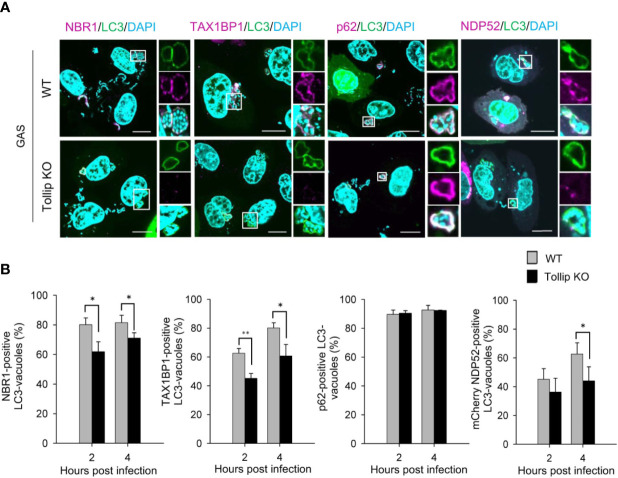
Tollip is required for the recruitment of NBR1, TAX1BP1, and NDP52 to GAS-containing LC3 vacuoles. (A) Wild-type and Tollip-knockout HeLa cells were transfected with EmGFP-LC3 or co-transfected with EmGFP-LC3 and mCherry-NDP52. After infecting with GAS for 4 h, endogenous NBR1, TAX1BP1, and p62 were labeled with antibodies. Insets: enlarged boxed areas; top: EmGFP-LC3; middle: autophagy receptors; bottom: merged image. All images are representative of 3 independent experiments. Scale bar, 10 μm. (B) Percentages of recruitment of autophagy receptors to GAS-containing autophagosome-like vacuoles: NBR1, TAX1BP1, p62, and mCherry-NDP52 (from left to right). In each experiment, >50 LC3-positive vacuoles were evaluated per sample; bars: means ± SD of 3 independent experiments. *P < 0.02, **P < 0.01.